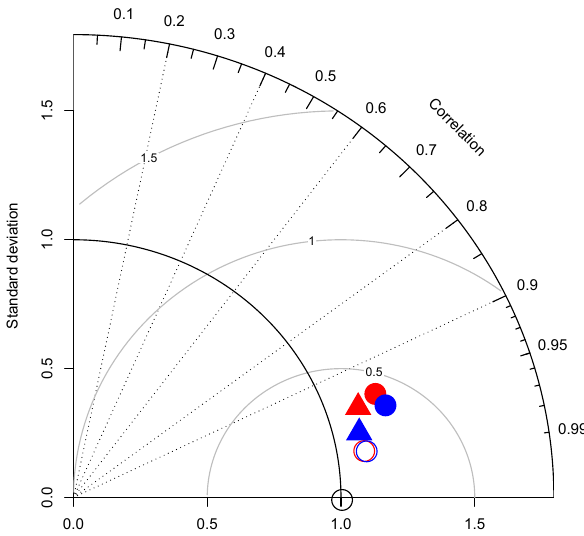
Figure 5. Normalized Taylor diagram on the ERA-Interim an- nual mean surface temperature for the standard CTRL experiment (red) and a selected downscaling experiment (with z q = 2000m, α min q = 0 . 8 and f s = 0 . 6) (blue). The circles depict the score when all grid points are considered, whilst the triangles stand for points with an elevation greater than 800m. The filled symbols correspond to the Taylor diagram computed on the high-resolution grid, whilst the empty symbols are for the T21 grid. In this figure, the met- rics (standard deviation, correlation and root mean square error) are computed from the annual mean climatic variables. The standard deviation in the observations is used to normalize the standard de- viations and the root mean square error.